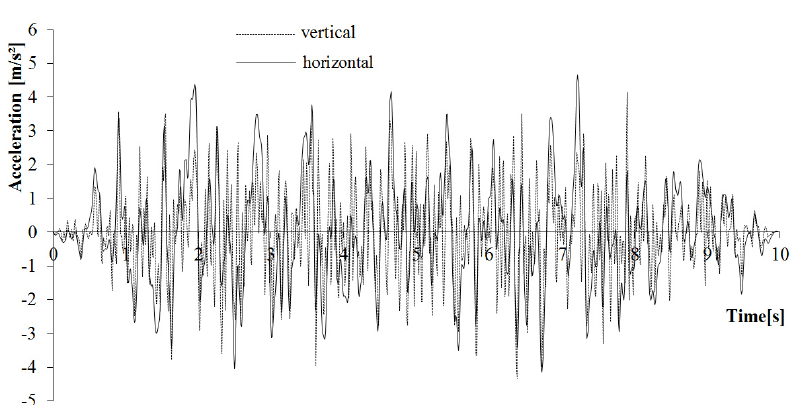
Figure 12. Synthetically generated acceleration time histories.